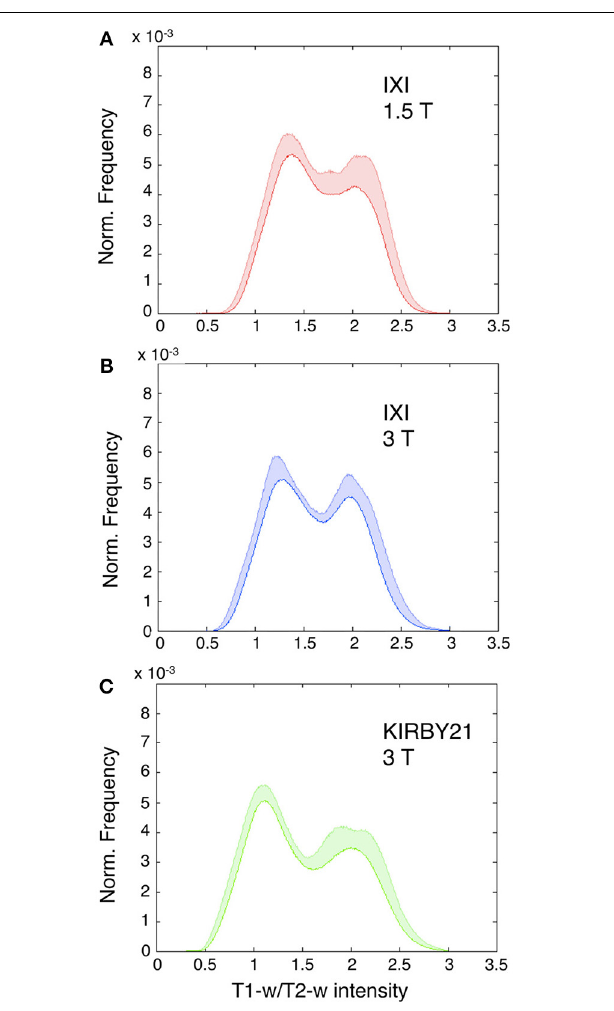
FIGURE 7 | Histograms of intensities in calibrated T1-w/T2-w images. Mean T1-w/T2-w histograms (with standard deviation in colored shade) are presented for the IXI 1.5 T (A) , IXI 3 T (B) , and KIRBY21 3 T (C) datasets. In agreement with the scaling algorithm, the calibrated T1-w/T2-w images exhibit comparable intensity scales with a reduced inter-subject variability for each dataset. Note the normalized frequency on the vertical scale obtained as the ratio of each subject-specific histogram to the total area beneath the curve.